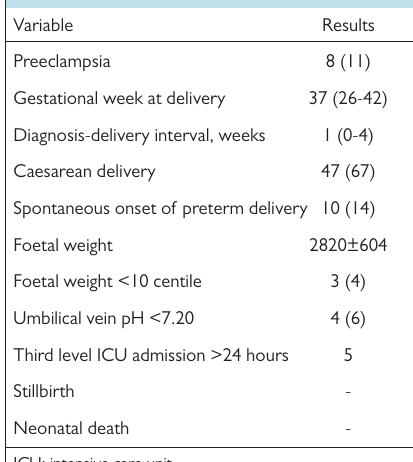
Table 2. Follow-up and delivery outcomes. Data are presented as n (%), mean ± standard